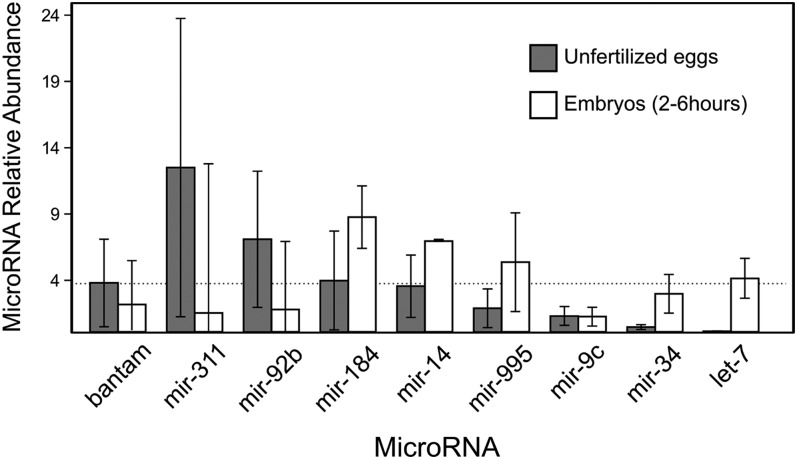
Quantification of selected maternal microRNAs in eggs and embryos. Levels of microRNA mature products in unfertilized eggs with respect to average bantam-3p levels from quantitative polymerase chain reaction assays (gray boxes; see Materials and Methods), and levels of microRNA mature products detected in 2- to 6-hr embryos with respect to levels in unfertilized eggs. Error bars are for three biological replicates. Dashed line indicates the levels of bantam-3p as a reference.